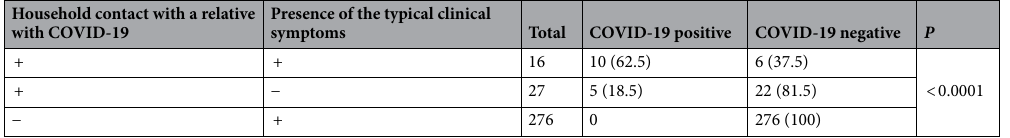
Table 2. Assessment of the risk of COVID-19 according to epidemiological data and the presence of clinical symptoms. Data are presented as numbers (%). In our group, there were no asymptomatic children without any contact with an infected